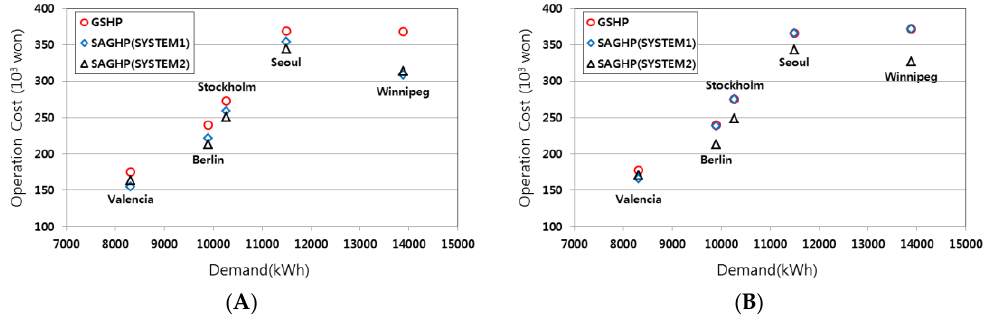
Figure 10. Operation cost calculation according to five different climate locations. ( A ) Day; ( B ) Night.